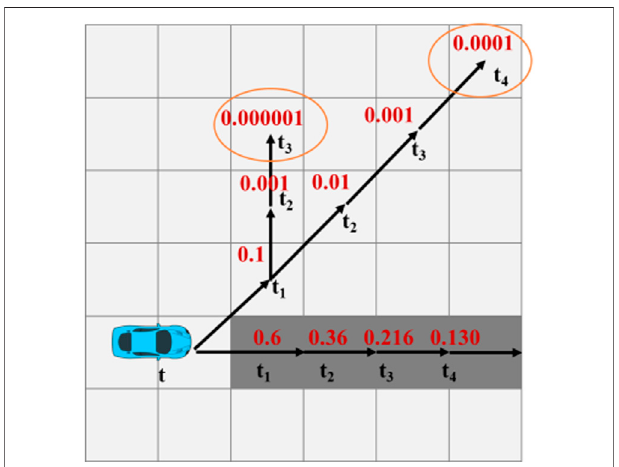
FIGURE 18 | Very low probability value of unexpected direction.